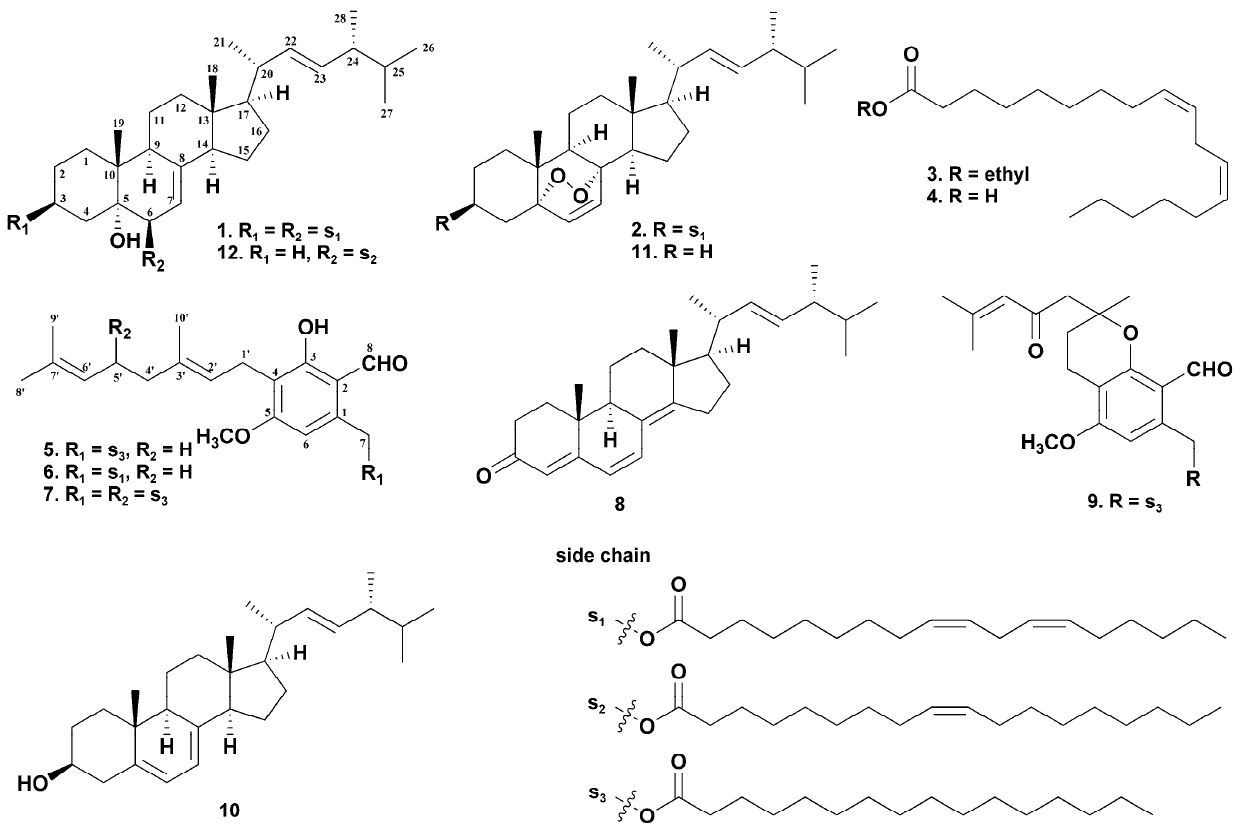
Figure 1. Chemical structures of compounds 1 – 12 .